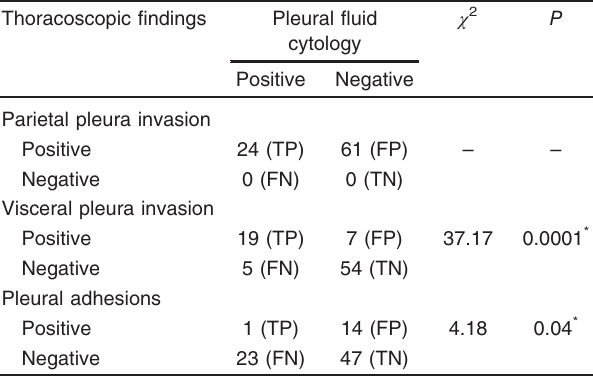
Relations between thoracoscopic findings and cytological results.